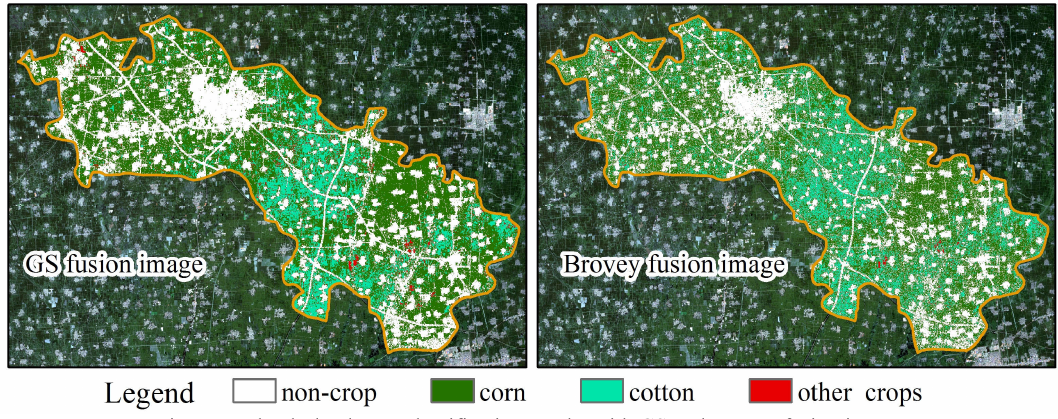
Figure 5. The dryland crop classification results with GS and Brovey fusion